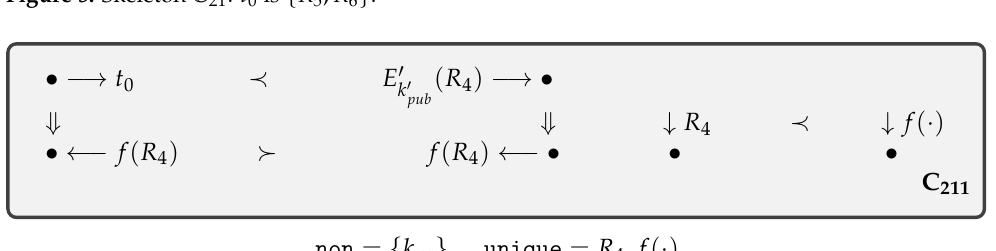
Figure 5. Skeleton C 21 : t 0 is { R 5 , R 6 } .